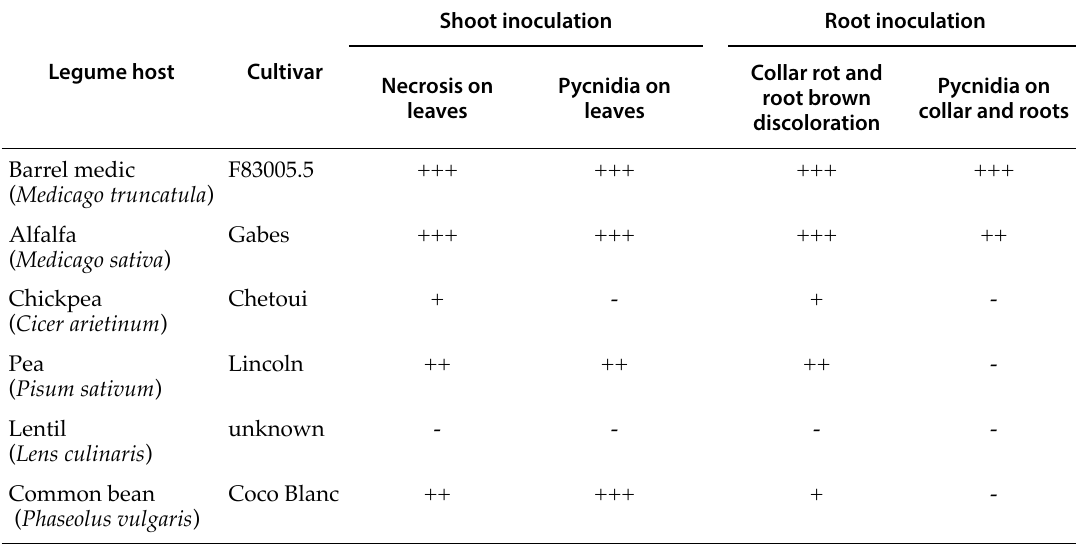
Table 5. Host and organ specialization of Phoma medicaginis inoculated on six legume species. Legume host Cultivar